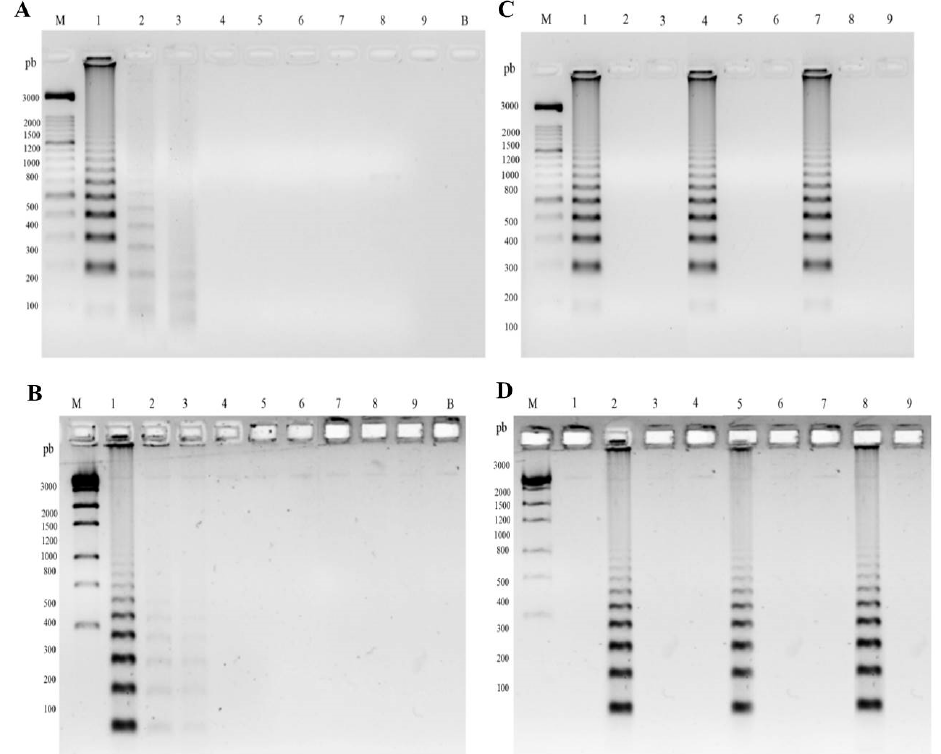
Figure 2. Specificity and limit of detection of padlock probes FOP and FOM by Rolling Circle Amplification (RCA). ( A ) Sensibility of padlock probe FOP amplified by RCA in internal transcribed region (ITS) amplicons of F. pedrosoi (CBS 271.37). ( B ) Sensibility of padlock probe FOM amplified by RCA in ITS amplicons of F. monophora (CBS 269.37). M, molecular marker 1 Kb; B, blank; 1 to 9, 2.88 × 10 9 , 2.88 × 10 8 , 2.88 × 10 7 , 2.88 × 10 6 , 2.88 × 10 5 , 2.88 × 10 4 , 2.88 × 10 3 , and 2.88 × 10 2 , 2.88 × 10 1 copies per tube, respectively. ( C,D ) Specificity of padlock probe FOP and FOM, respectively, amplified by RCA in plant and soil samples. In vitro specificity analysis: 1–3, total DNA of plant Mimosa pudica ; 4–6, total DNA of soil, F. pedrosoi , F. monophora , and Fonsecaea erecta , respectively; 7–9, in vivo specificity analysis of Bactris gasipaes in a vessel after injury with F. pedrosoi , F. monophora , and F. erecta , respectively.